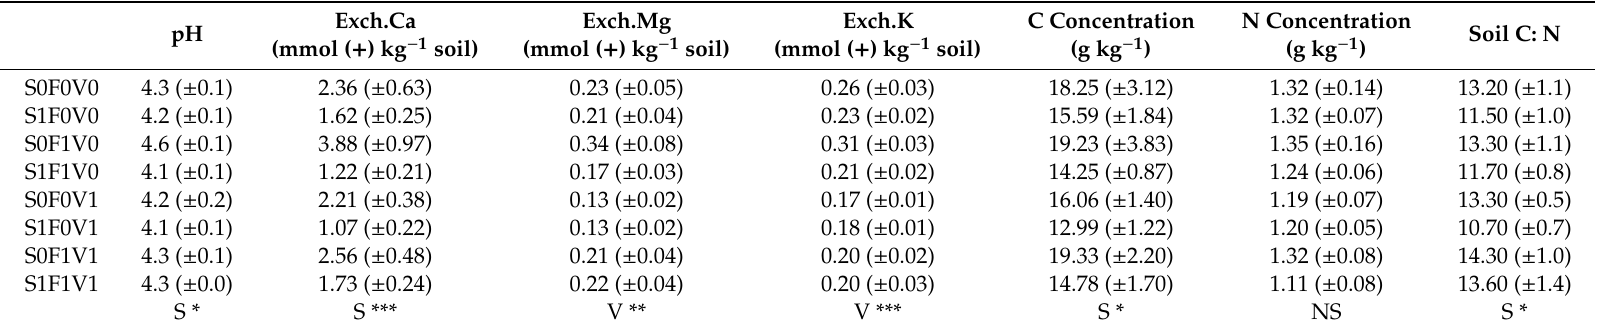
Table 3. Impact of silvicultural treatments on surface mineral soil (0–15 cm) properties, 27 years after establishment of a white pine plantation ( n = 96). S = scarification, F = fertilization, V = vegetation control, 0 = no treatment, 1 = application of treatment. Values are the mean, and standard errors are presented in